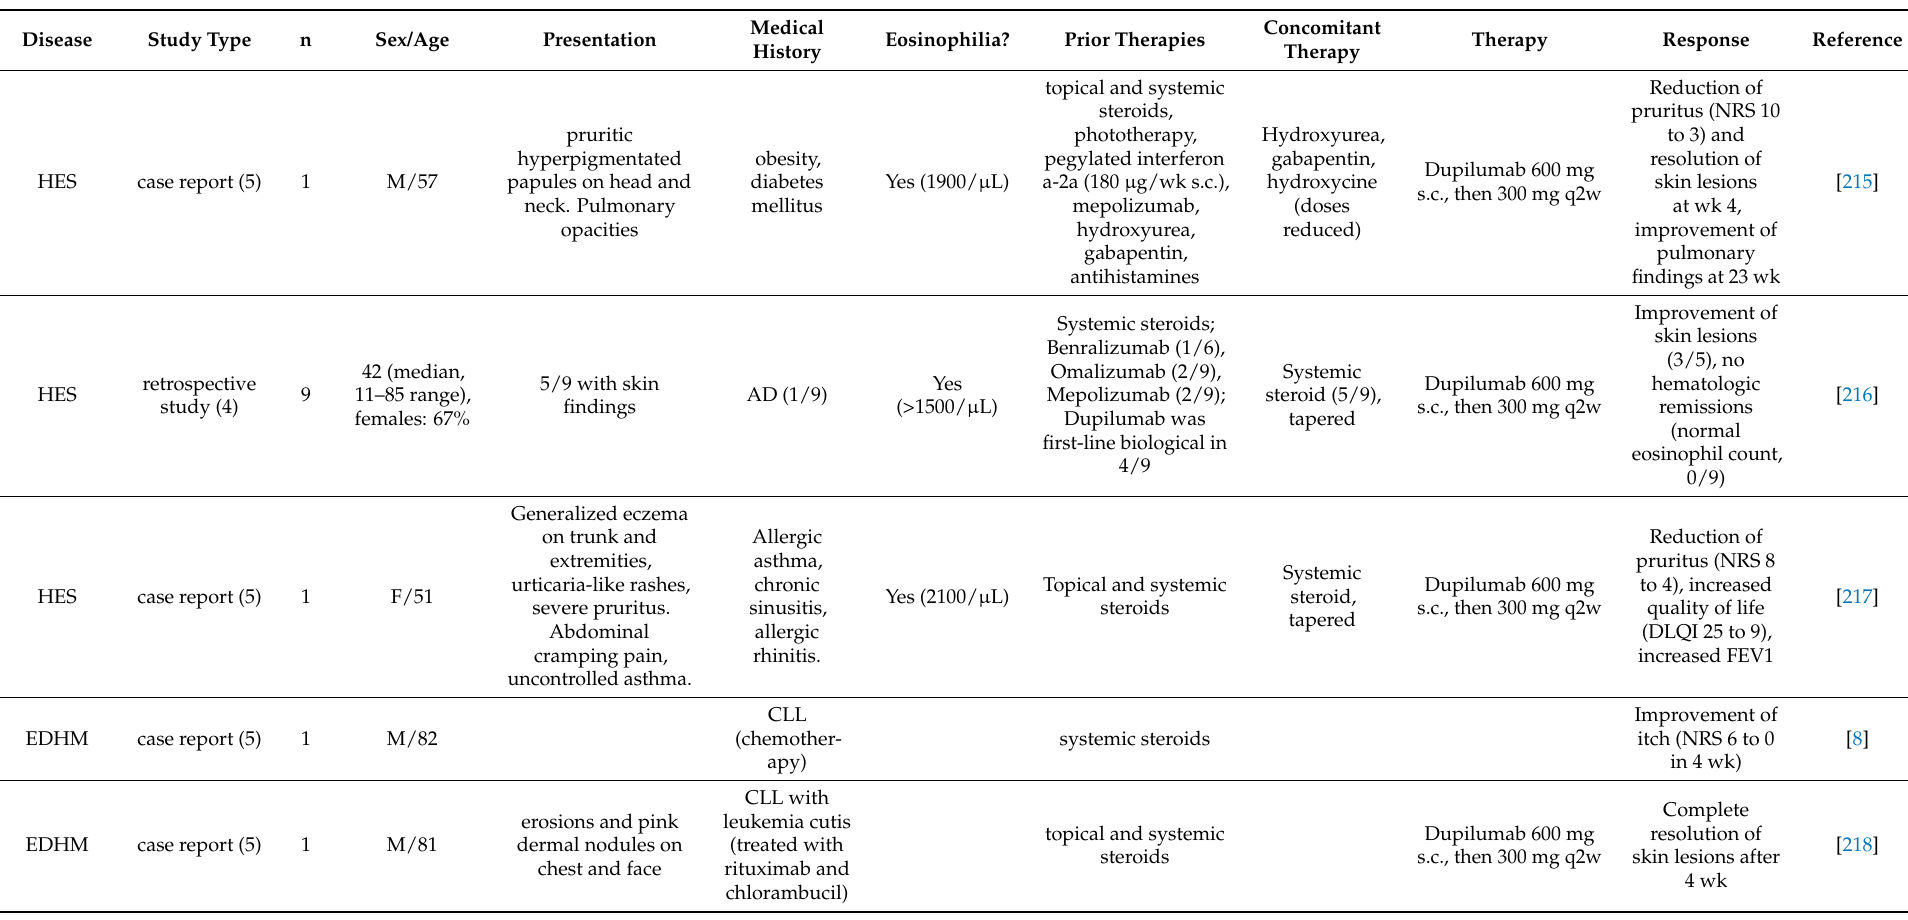
Table 7. Eosinophilic